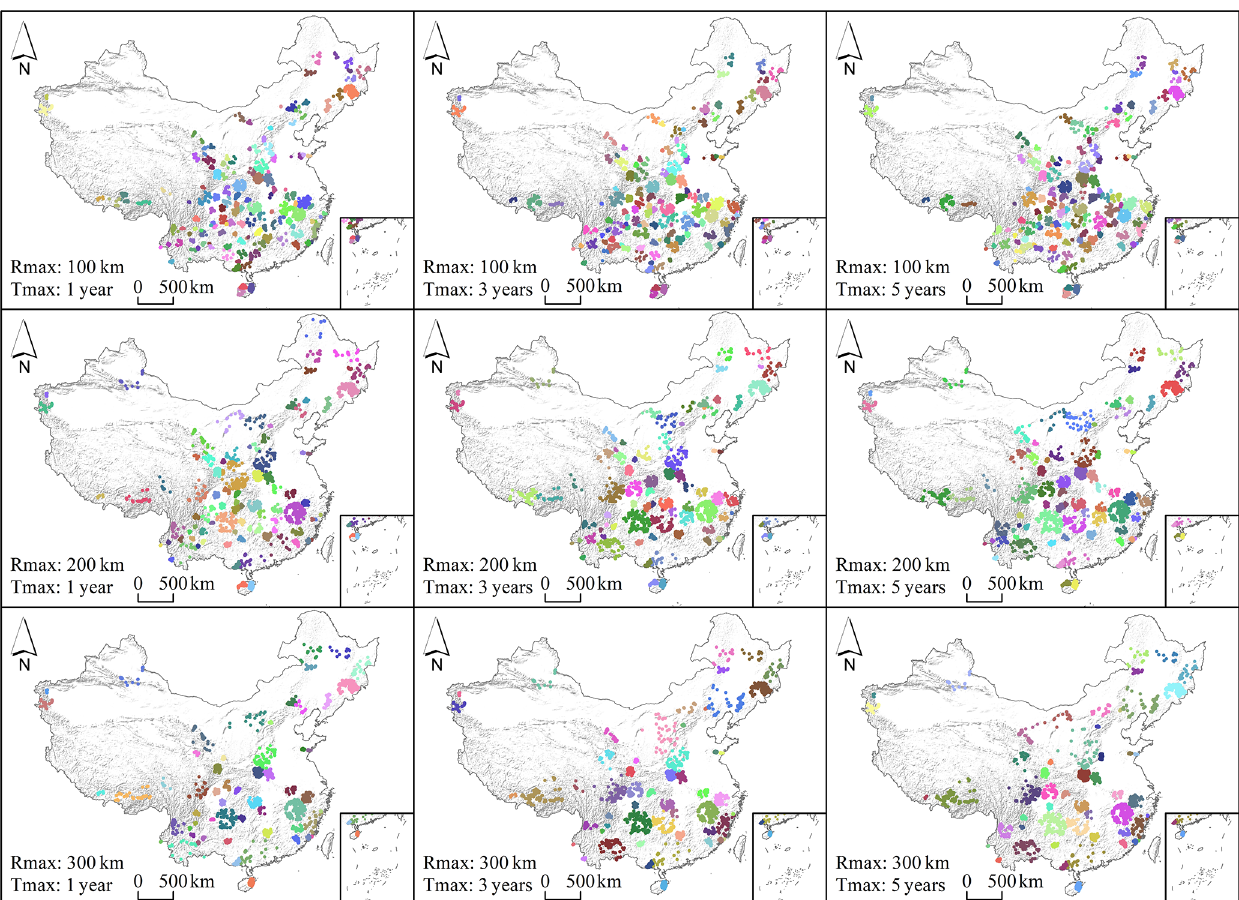
Figure 4. Significant ( p < 0 . 005) spatiotemporal clusters of flash flood disasters in China during